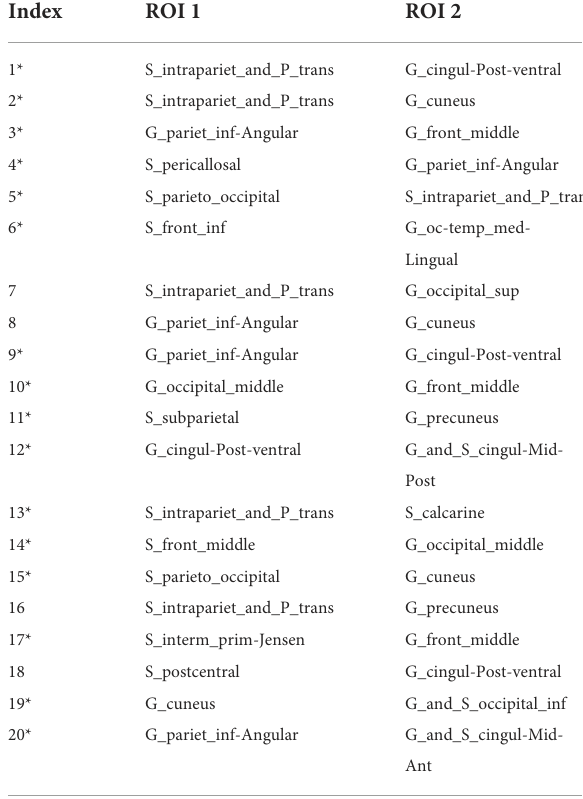
TABLE 6 The nodes and edges involved in the FC features with high overlap rate (12/14) among training with random sample